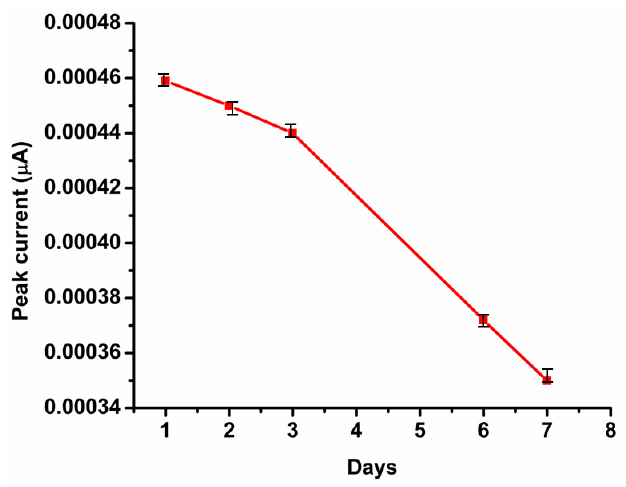
Figure 11. Stability of the Fe(TPFPP)Cl/AuNPs-S-Gr sensor for a period of 7 days. Comparison between results obtained using the proposed method and those obtained using chromatographic methods is shown in Table 4.